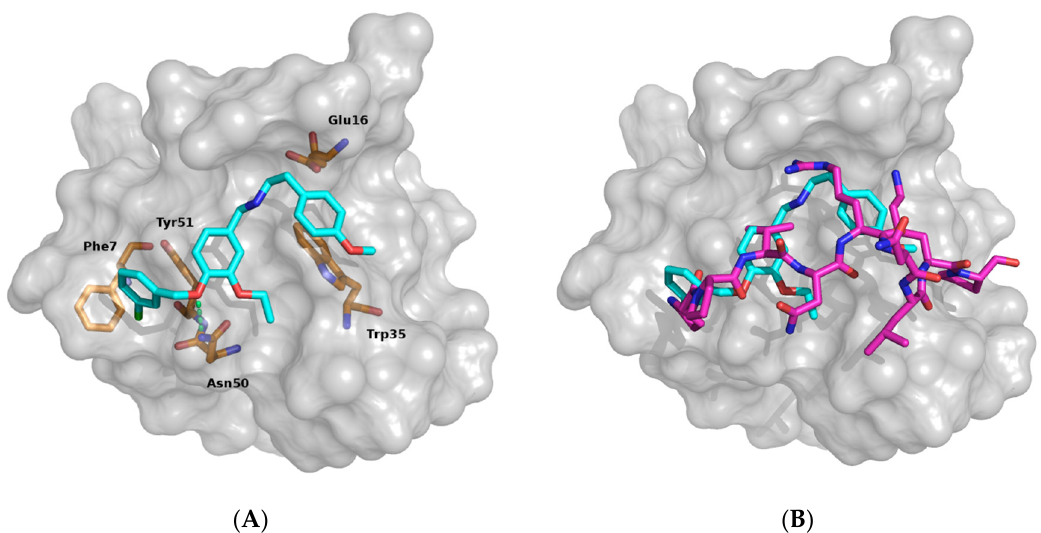
Figure 2. AN-465-J137-985 proposed binding mode. ( A ) Proposed binding mode for derivative AN-465-J137-985. The Grb2 C-SH3 domain is reported as gray surface. AN-465-J137-985 is reported as cyan stick; residues involved in contacts are reported as light green. H-bond is depicted as yellow dot lines. ( B ) Superimposition of AN-465-J137-985 proposed binding and Gab2a core binding. Importantly, in the absence of specific experimental data, the proposed binding mode should be considered solely as a plausible hypothesis.